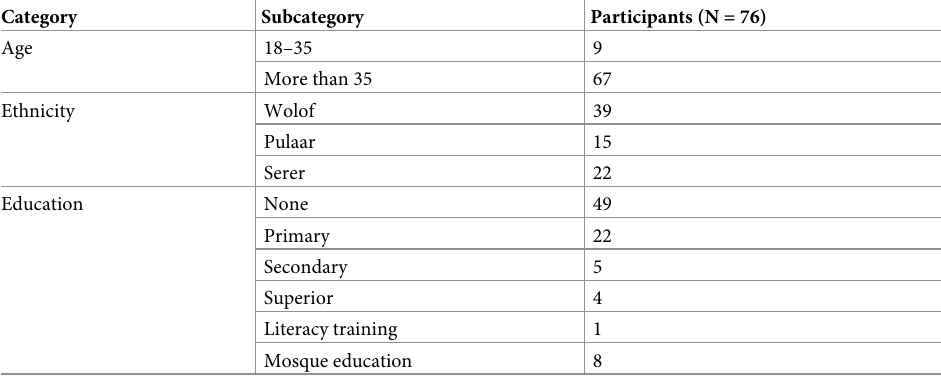
Table 1. Socio-demographic data on the participants of focus groups in Niakhar and Fatick in May 2017.